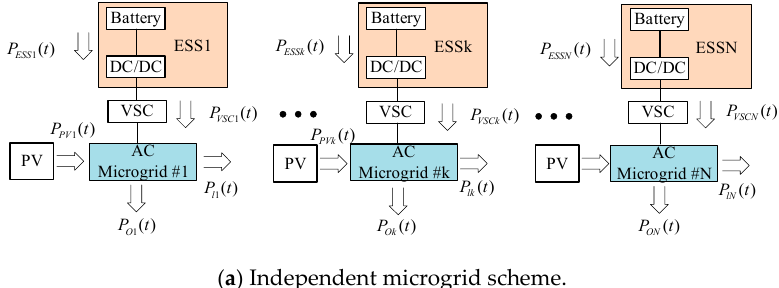
Figure 1. Configuration of the flexible multi-microgrid interconnection scheme.